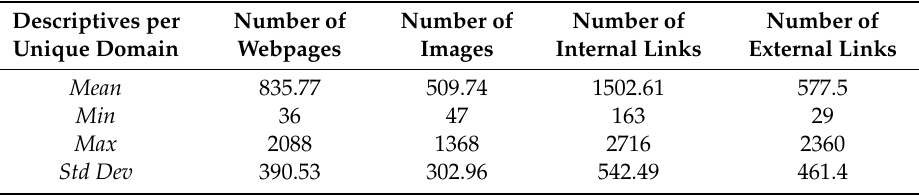
Table 1. Descriptive statistics from the examined 171 unique cultural heritage institution websites.